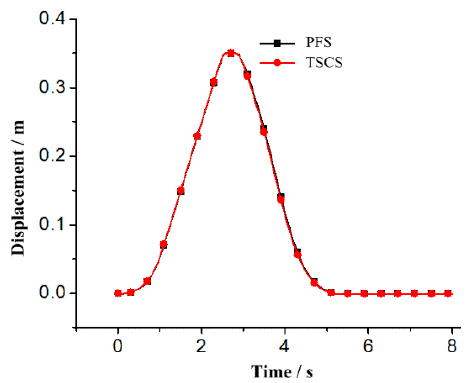
Figure 8. Displacement curves of the arm cylinder of the two systems. Appl. Sci. 2020 , 10 , x FOR PEER REVIEW